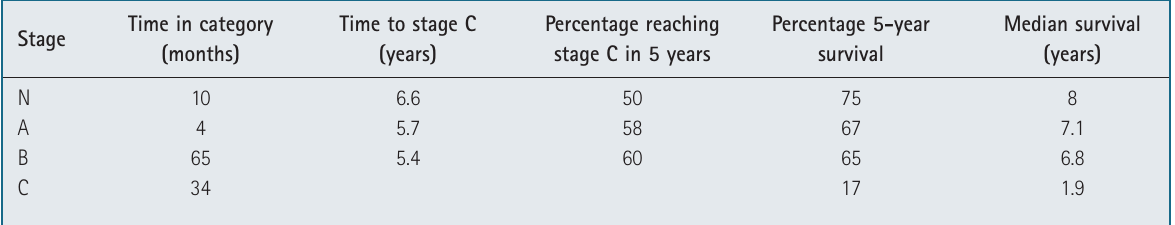
TABLE I. DISEASE STAGES IN HIV-INFECTED CHILDREN IN THE USA, 1982 - 1993, PRIOR TO HIGHLY ACTIVE ANTIRETROVIRAL THERAPY